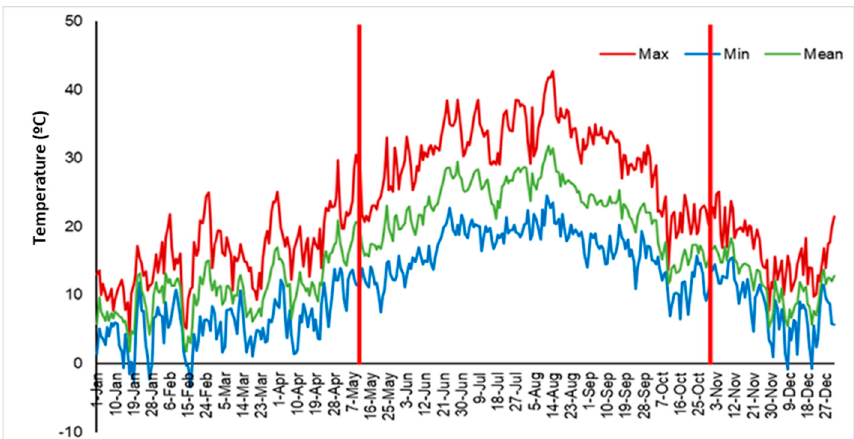
Figure 1. Temperature trend: maximum, minimum, and mean temperature (°C) recorded during the growing season in the open field. The vertical red lines indicate the start and end of the trial period.